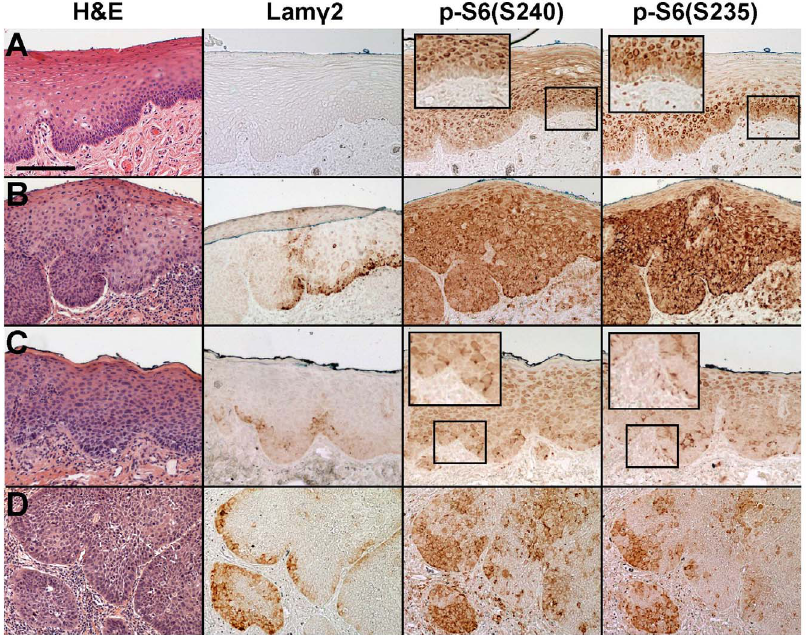
Figure 2. Coincidence of p-S6(S235) and p-S6(S240) detectable in human oral dysplastic lesions and SCCs invivo . Sections of normal ( A ) and dysplastic ( B-C ) epithelium, and invasive SCC ( D ), stained with H&E and immunostained for Lam c 2, p-S6(S240) and p-S6(S235). Scale bar: 200 m m. Enlarged insets of some regions are shown for easier viewing of p-S6 staining patterns. Panel A shows a region of Case 2, panel B of case 8, panel C of case 7, and panel D of case 4 as described in Table 1. Note that normal epithelium did not express Lam c 2 and neither S6 phosphorylation event was detectable in the basal cells. Cells in dysplasias and SCCs always showed coincidence of the two S6 phosphorylation events. Dysplasias varied with respect to frequency and intensity of Lam c 2 expression and S6 phosphorylation, with Lam c 2 cells representing a subset of p-S6 positive basal cells and invasive SCCs contained many Lam c 2 and basal layer p-S6 positive regions. doi:10.1371/journal.pone.0078979.g002 (Fig. 3A) disclosed that both the MEK inhibitor U0126 and the RSK inhibitor BI-D1870 reduced p-S6(S235), p-eIF4B, and